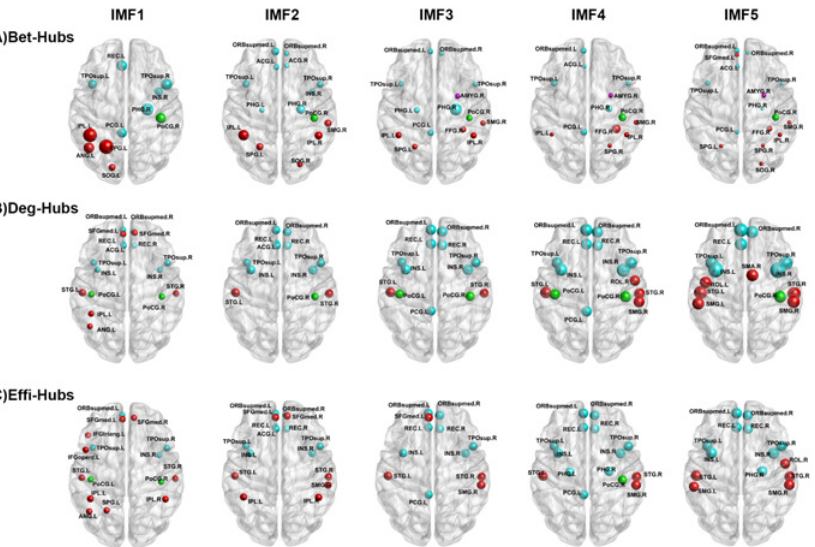
Fig 4. The spatial distribution of hub regions. Three dimensional rendering maps show hub regions defined by nodal betweenness (A), nodal weighted degree (B), and nodal efficiency (C) in five IMFs. The hub nodes shown in red, green, cyan and magenta color donate Associations, Primary, Paralimibic and Subcortical regions respectively as described by Achard et al. (2006) The size of the node represents their nodal topological characteristics. Hub regions are visualized using the BrainNet viewer (NKLCNL, Beijing Normal University). For the abbreviations of the regions, refer to Table 1.